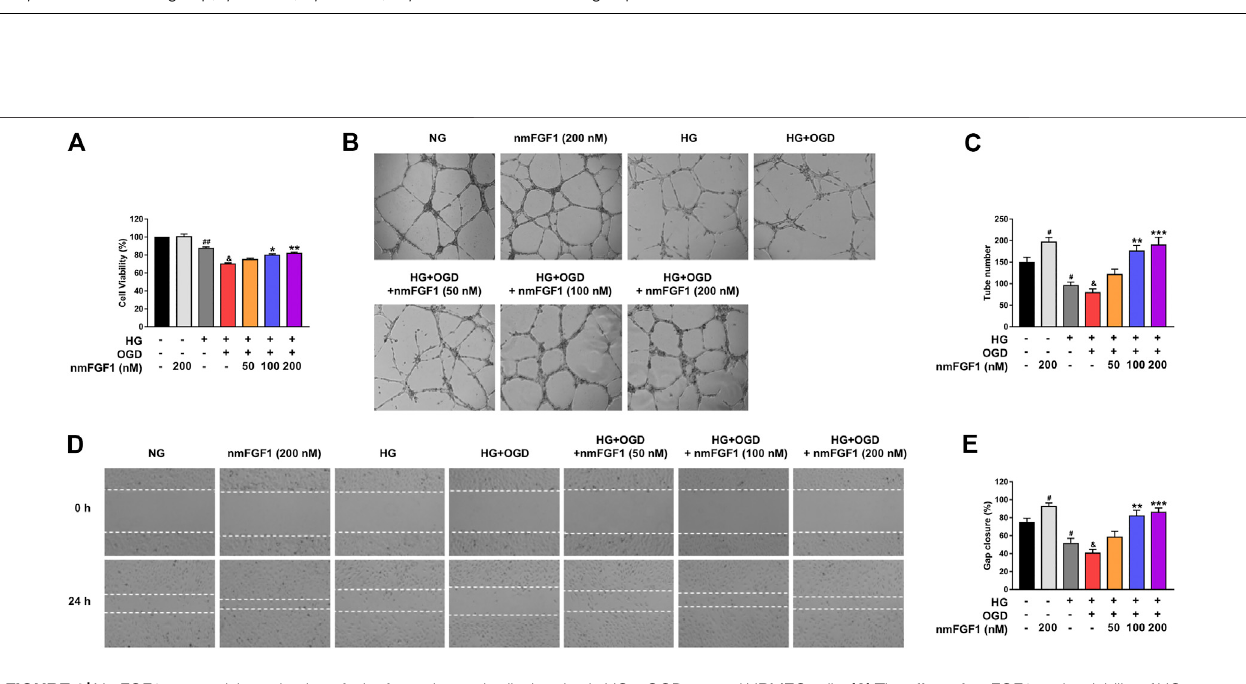
FIGURE4| NmFGF1reversedthereductionoftubeformationandcellmigrationinHG+OGD-treatedHBMECcells. (A) TheeffectofnmFGF1ontheviabilityofHG +OGD-treatedHBMECcells. (B) TheeffectsofnmFGF1ontubeformation,originalmagni fi cation: × 40. (C) Quantitativeanalysisofthenumberofcapillary-liketubes. (D) Wounding healing migration assay of HBMEC cells; images show wound areas as observed by phase-contrast microscopy, original magni fi cation: × 40. (E) The migration ratio was calculated using Image Pro Plus software (n (cid:2) 3). Date are presented as means ± SEM. # p < 0.05, ## p < 0.01 vs. NG group; & p < 0.05 vs. HG group; * p < 0.05, ** p < 0.01, *** p < 0.001 vs. HG + OGD group.